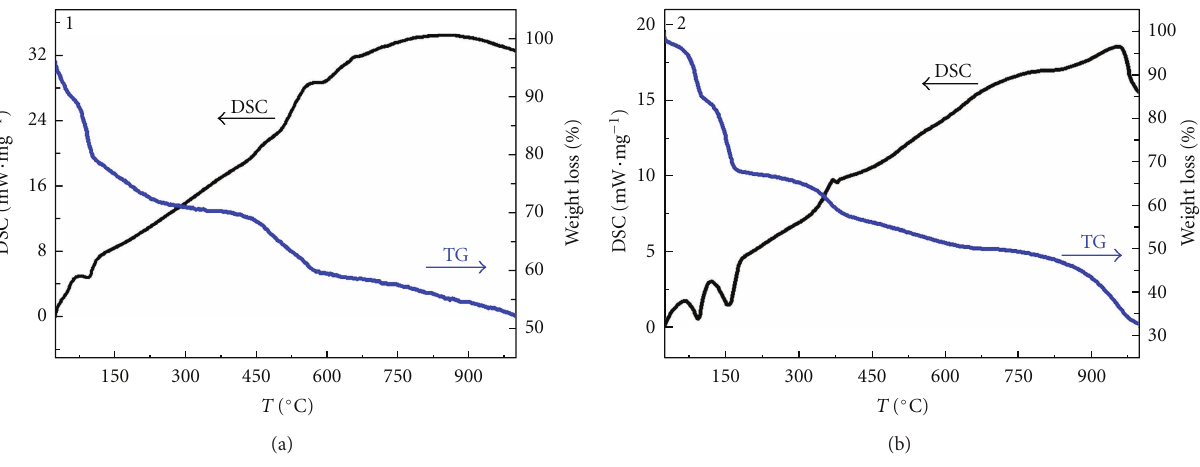
F 5: e TGA-DSC curves of 1 (a) and 2 (b).